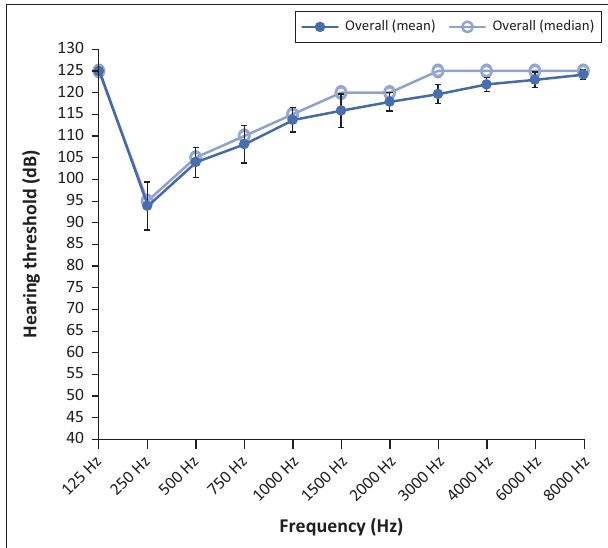
FIGURE 1: Preoperative hearing threshold levels overall.